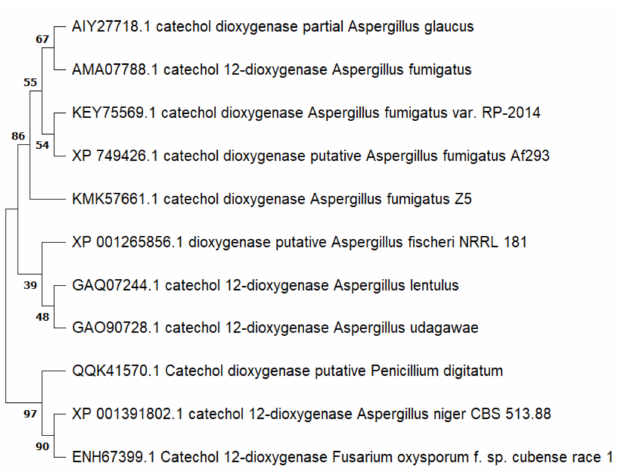
Figure 8. Phylogenetic tree of homologous catechol 1,2-dioxygenase amino acid sequences in fungi (NCBI). The analyses were performed by the maximum likelihood method using the MEGA 11